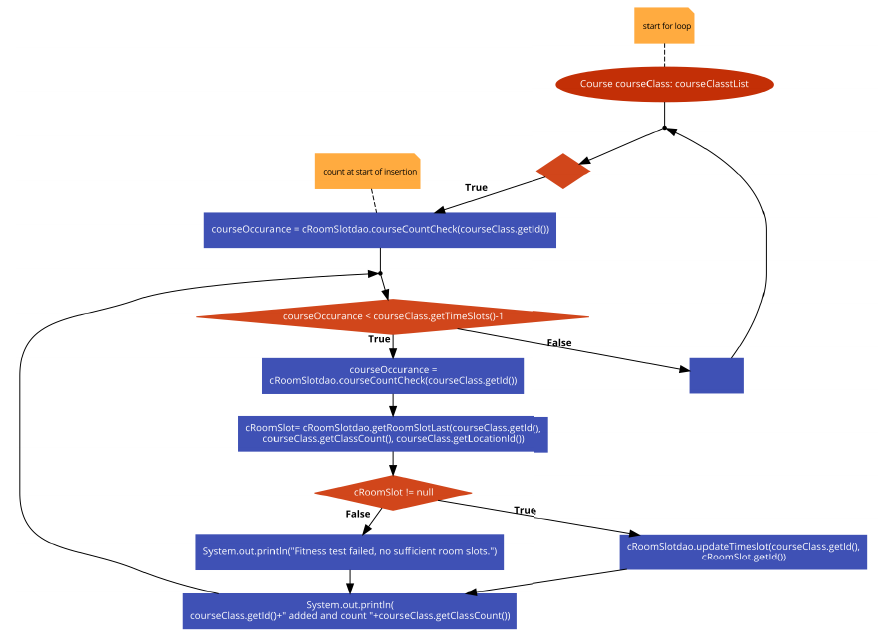
Fig. 4. Algorithm without